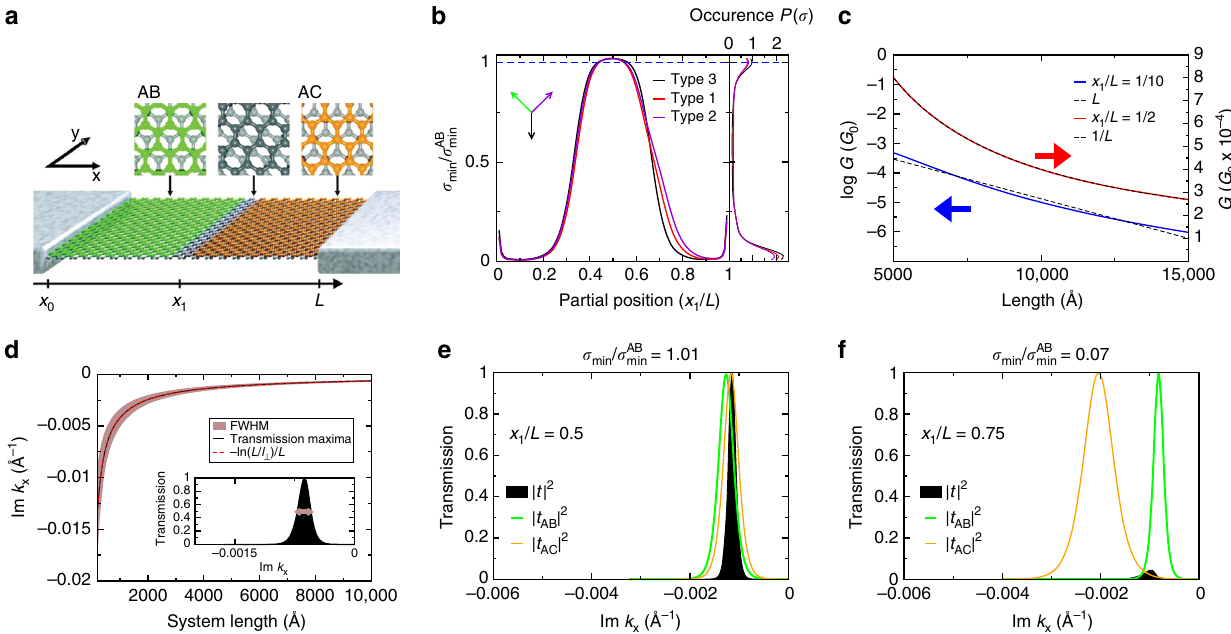
Fig. 1 Resonant and blocked transport states for a single partial dislocation in bilayer graphene. a Schematic illustration of a bilayer graphene ribbon consisting of two domains of structurally perfect Bernal stacking connected by a single partial dislocation, with the grey area depicting the fi nite non-Bernal transition region and the upper panels displaying the structure of the local AB, non-Bernal, and AC stacking geometries. b Conductivity σ at the Dirac point as a function of the partial position x 1 / L , ranging from minimal metallic conductivity at x 1 / L = 1/2 to insulating behaviour at x 1 / L = 2/10. Calculations are shown for three different partial Burgers vectors of the partial dislocation. The right hand plot shows the probability distribution function of conductivities, indicating the likelihood of occurrence for a given transport state. c Dependence of the conductance G on sample length for the metallic ( x 1 / L = 1/2) and insulating ( x 1 / L = 2/10) partial positions, showing 1/ L and exponential dependence, respectively. d Transport through a single terrace, showing the transmission function for L = 1 μ m (inset), and (main panel) the maximum and full width half maximum ( FWHM ) of the transmission resonance as a function of length. e , f Transmission probability of charge carriers through the full system ( | t | 2 ), and through the individual AB ( | t AB | 2 ) and AC ( | t AC | 2 ) terraces separately connected to leads, for a conducting and insulating partial position. Evidently underpinning the conducting state is overlap of the individual terrace transmission resonance peaks e , with transport blocking occurring when these are well separated ( f